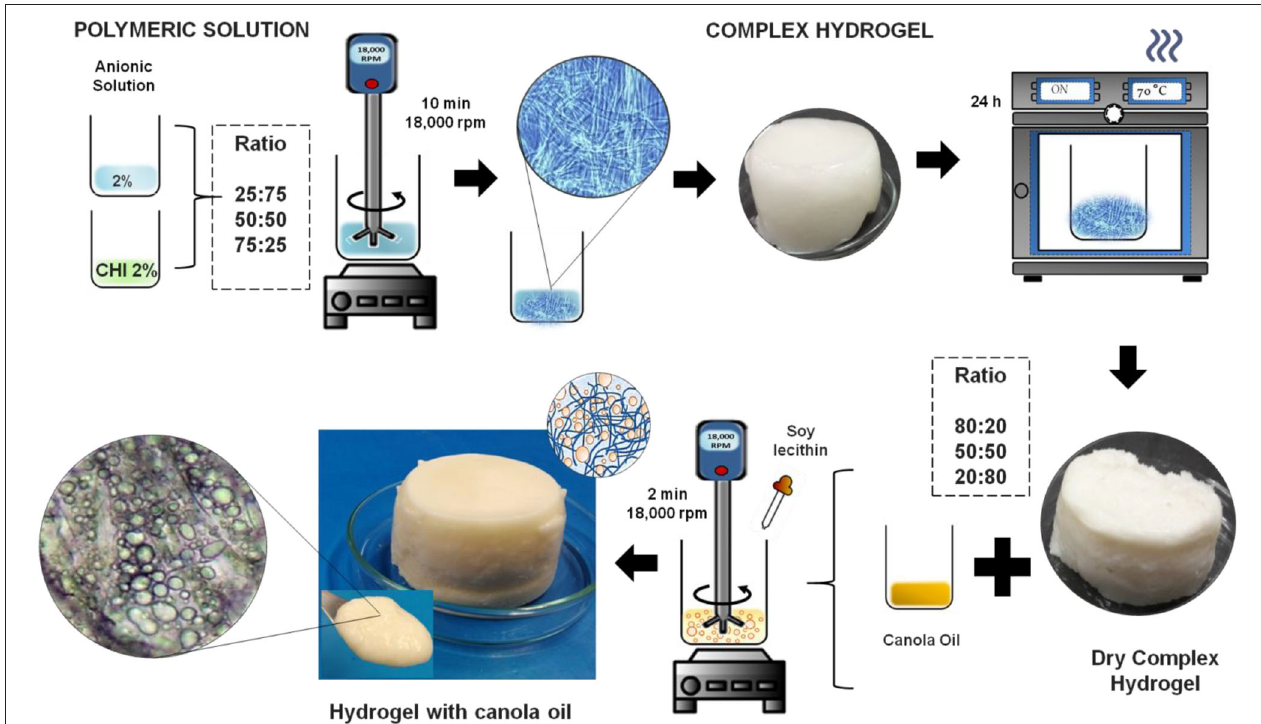
FIGURE 1 | Process of oil addition to hydrogels